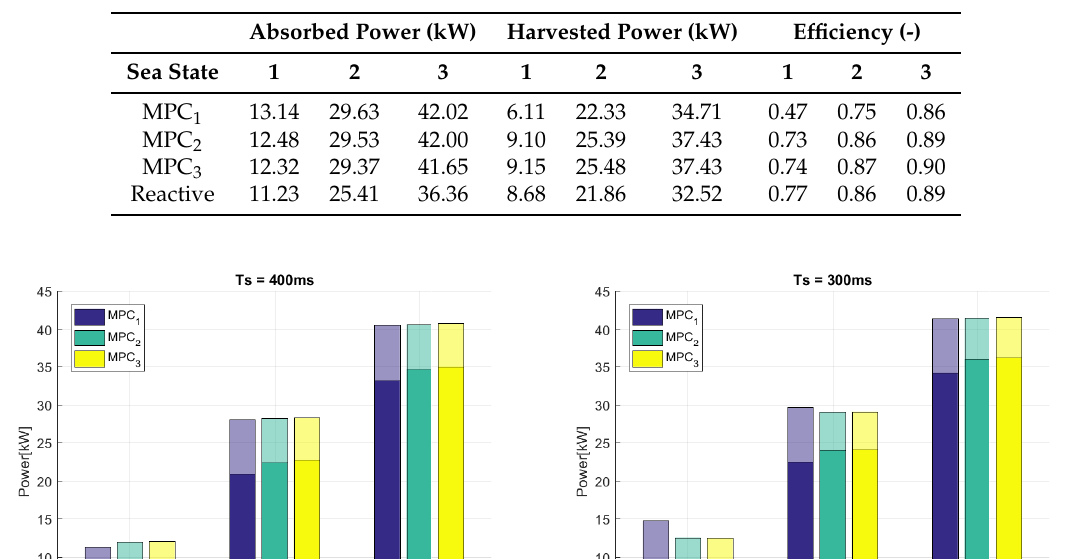
Table 3. Average absorbed power, harvested power and efficiency for three different sea states for different WPEA’s.